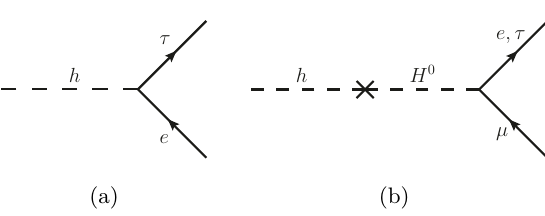
Figure 32 . Lepton Flavour Violating decays of Higgs